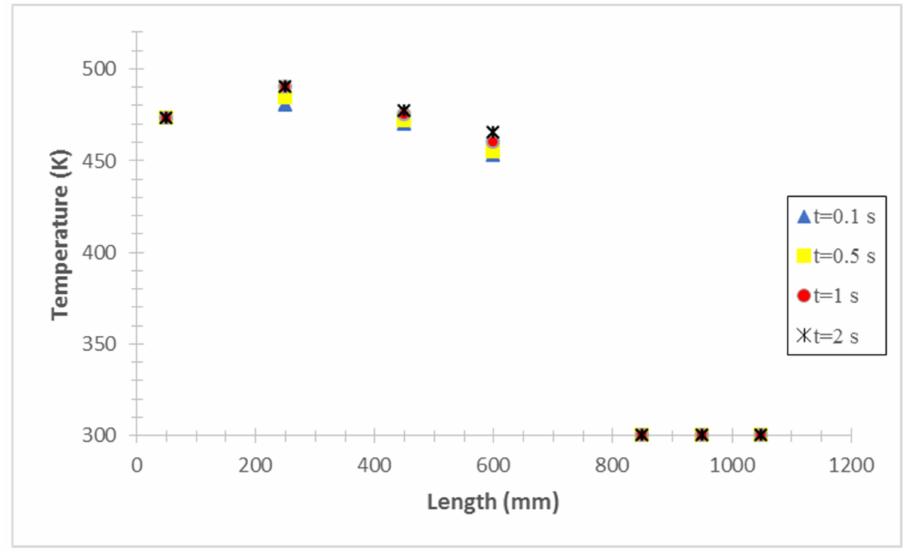
Figure 12. Temperature distribution on TPCT for different times at FR =